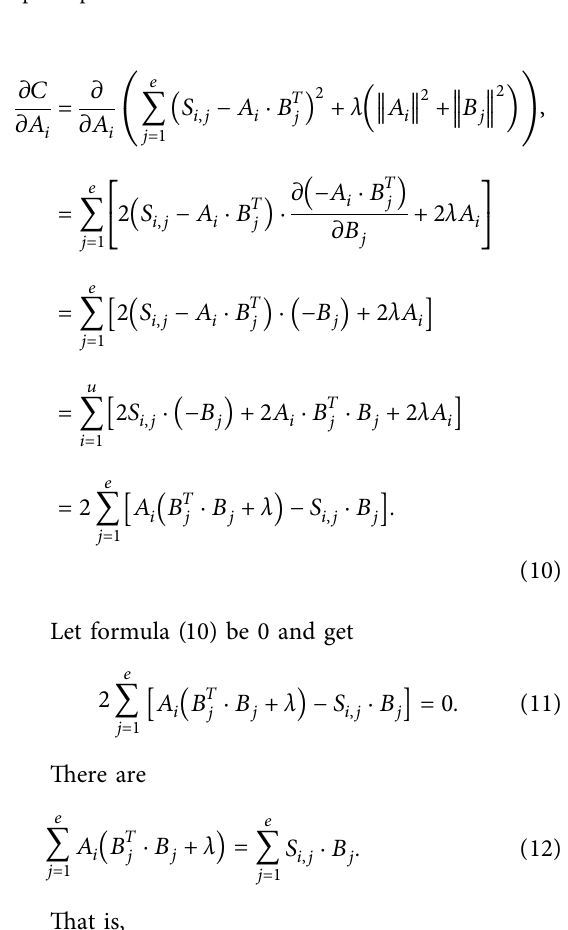
Figure 6: Data collection and update